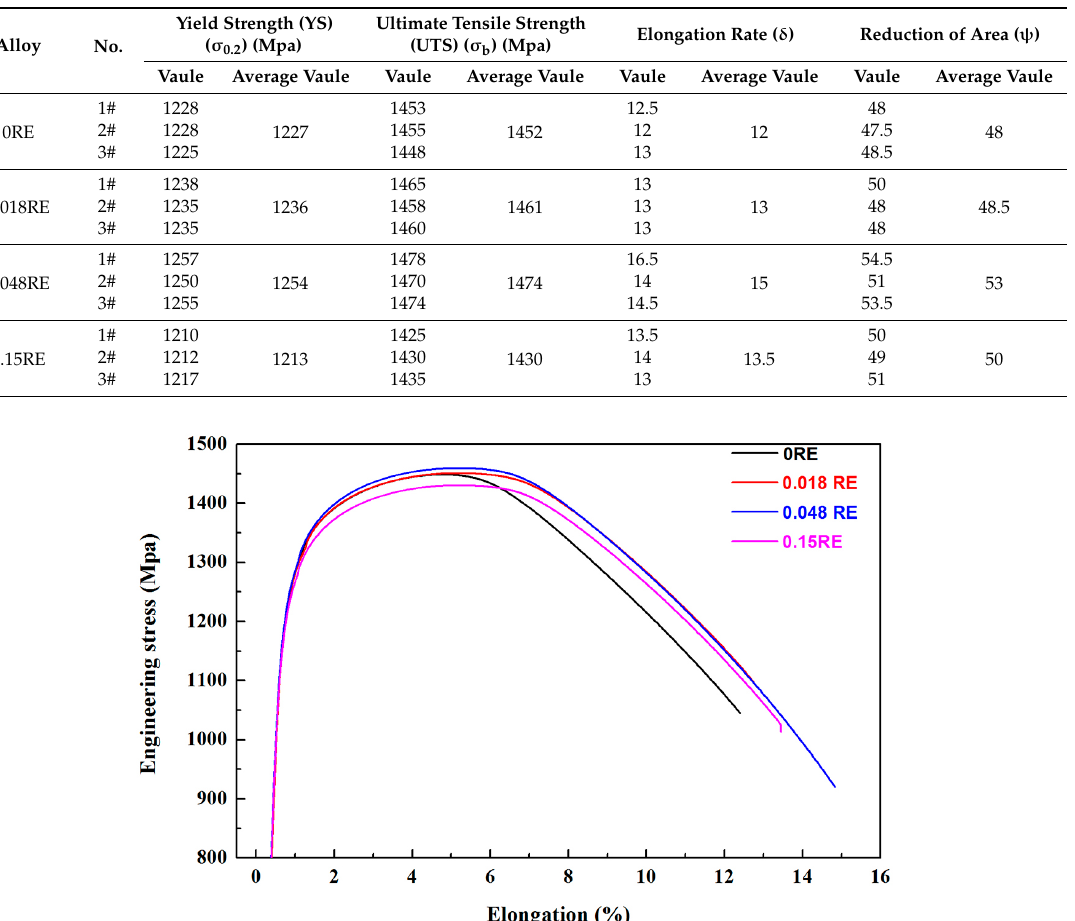
Table 3. Variation in tensile strength of each sample in response to different additions of RE.